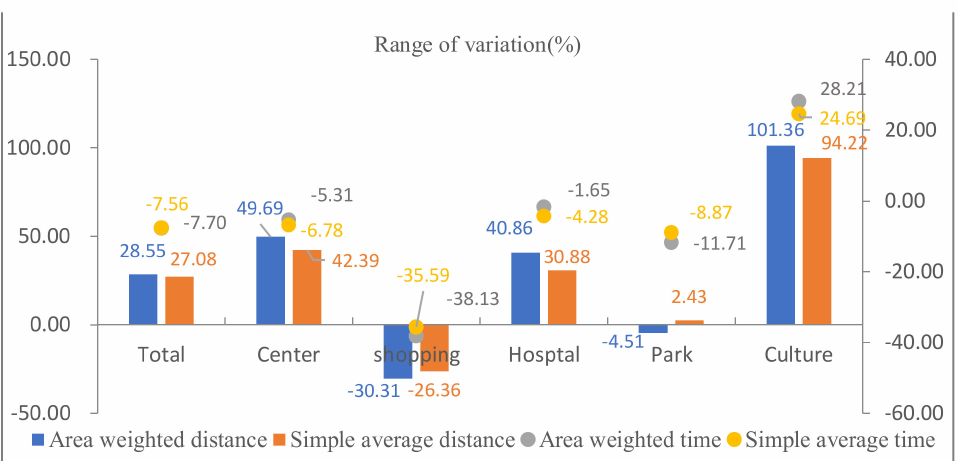
Figure 6. Comparison of variation in travel distance and time from 2000 to 2020 calculated by the area weighted and simple statistical average